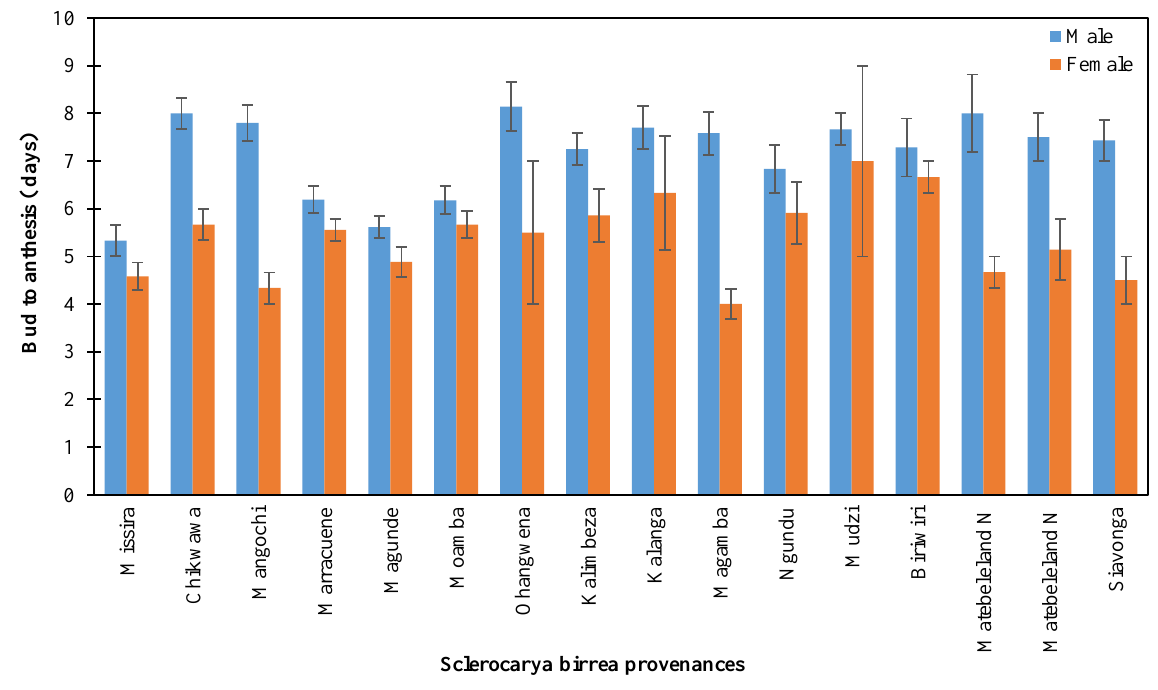
Figure 6. Variation between male and female in number of days from budding to anthesis among provenances of S.